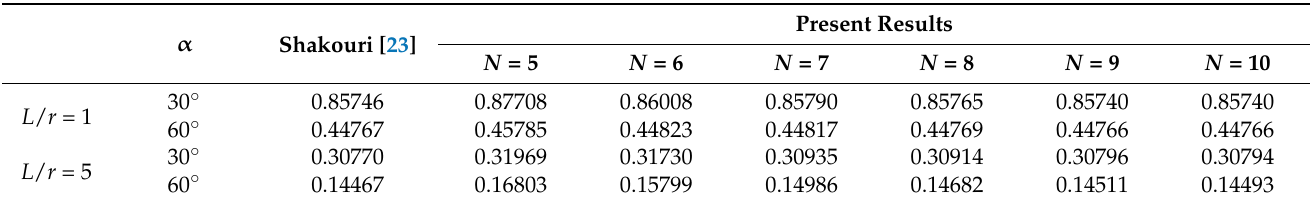
(cid:112) ρ ( 1 − µ 2 ) / E ) of a functionally graded